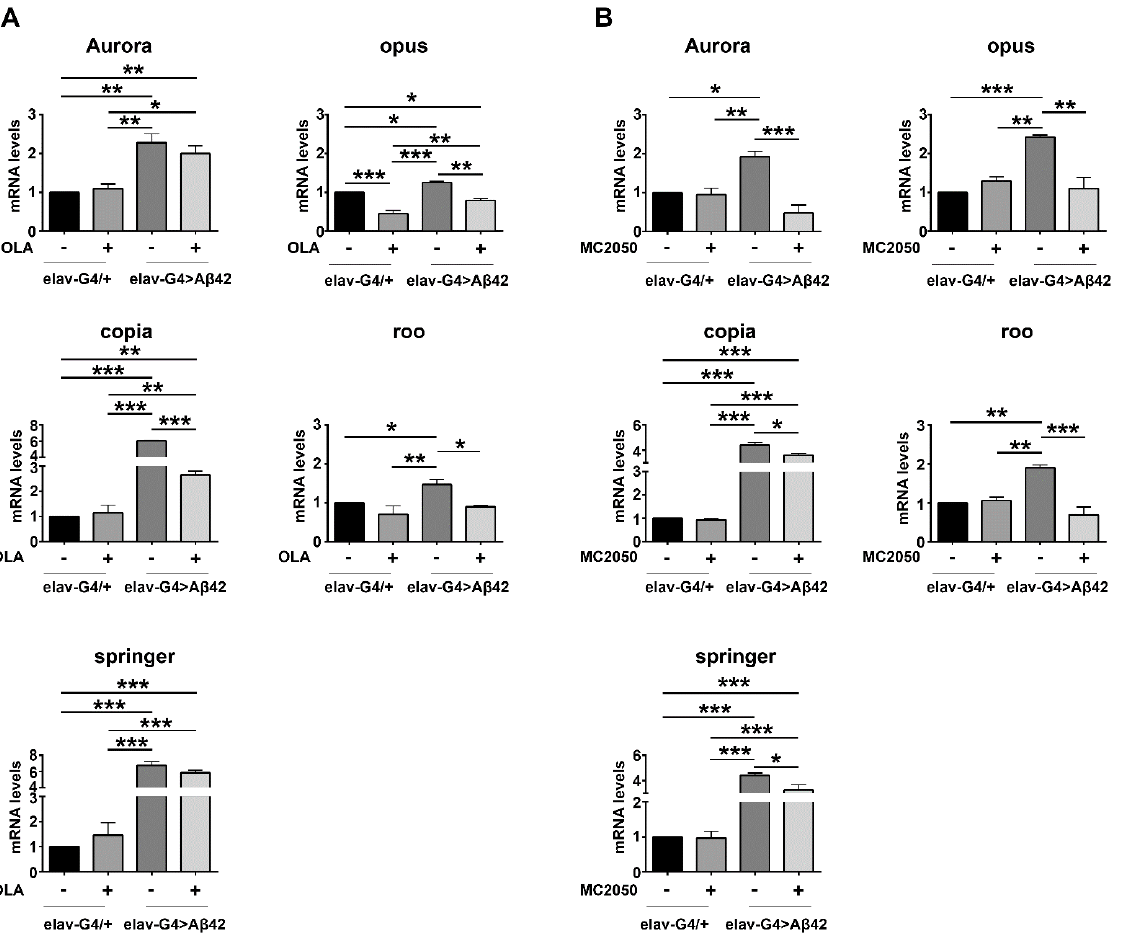
Figure 7. qRT-PCR analysis of transposable element expression in head tissues of flies expressing the pathogenic construct A β 42 in neurons ( elav-Gal4 > A β 42 ) treated or not with PARP-1 inhibitors olaparib ( A ) or MC2050 ( B ) relative to untreated controls ( elav-Gal4/+ ); heads were analyzed at 10–12 days post-eclosion; transcript levels were normalized to rp49 and displayed as fold change relative to untreated control flies ( elav-Gal4/+ ). Statistical significance was determined using the two-way ANOVA test followed by the Tukey test for multiple comparisons (* p < 0 .05, ** p < 0 .01, *** p < 0.001).